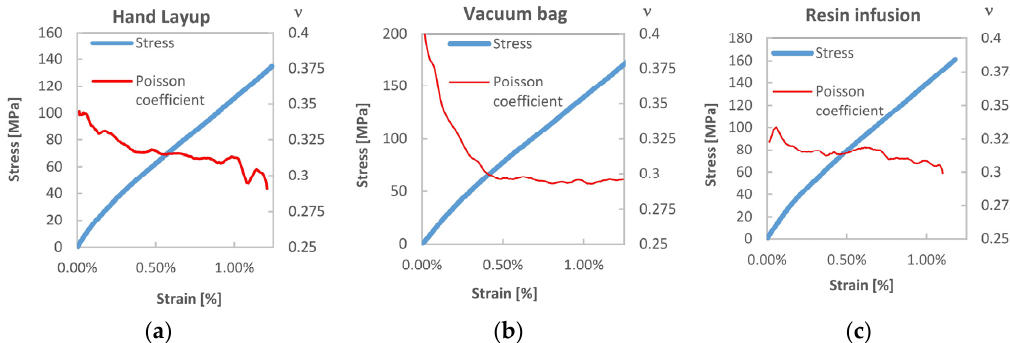
Figure 6. Evolution of Poisson’s coefficient with strain for the: ( a ) hand lay ‐ up; ( b ) vacuum bag and ( c ) resin infusion laminated composites.